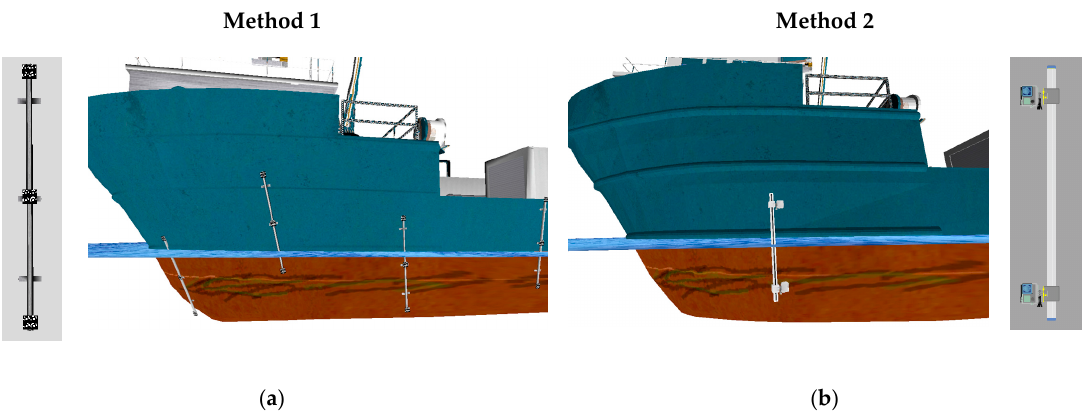
Figure 2. Example of a damaged boat that needs a 3D accurate reverse modelling of the damaged part placed underwater. The boat, a semi submerged object in floating condition can be surveyed with one of the two proposed methods using respectively for method one ( a ) some special linking targets fixed on the hull (e.g., with magnets or suction cups) or for method two ( b ) a synchronized stereo camera placed with a camera below and a camera above the water.